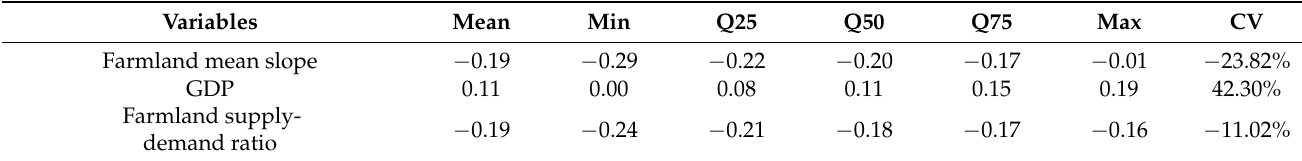
Table 5. Descriptive statistics of GWR model regression coefficients.